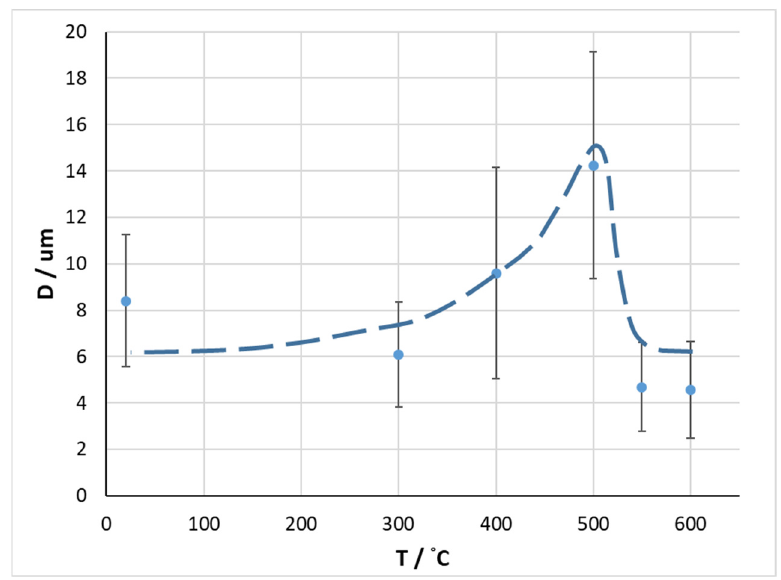
Figure 3. Dependence of the size of aluminum inclusions on the heat-treatment temperature.